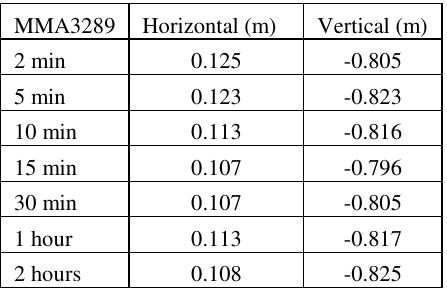
Table 1. Deviations in horizontal and vertical for MMA3289. It can be seen that there is a constant offset of about 0.114 m and - 0.812 m for the horizontal and vertical deviations respectively.